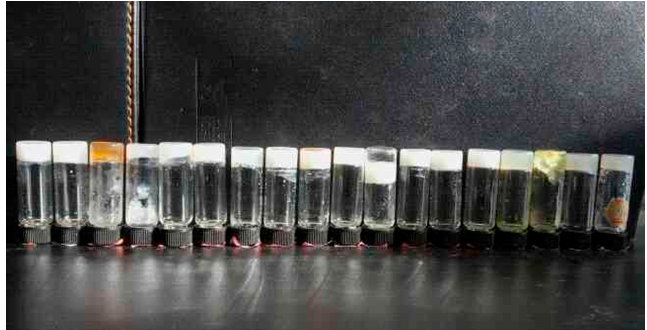
Figure 2. Photograph of TC16-Fl organogels in present used solvents (from left to right, nitrobenzene, acetone, DMF, aniline, pyridine, petroleum ether, n-hexane, ethanol, n-propanol, isopropanol, isooctanol, n-butanol, n-butyl acrylate, cyclohexanone, n-pentanol, 1,4-dioxane, cyclopentanone, and isopentanol).